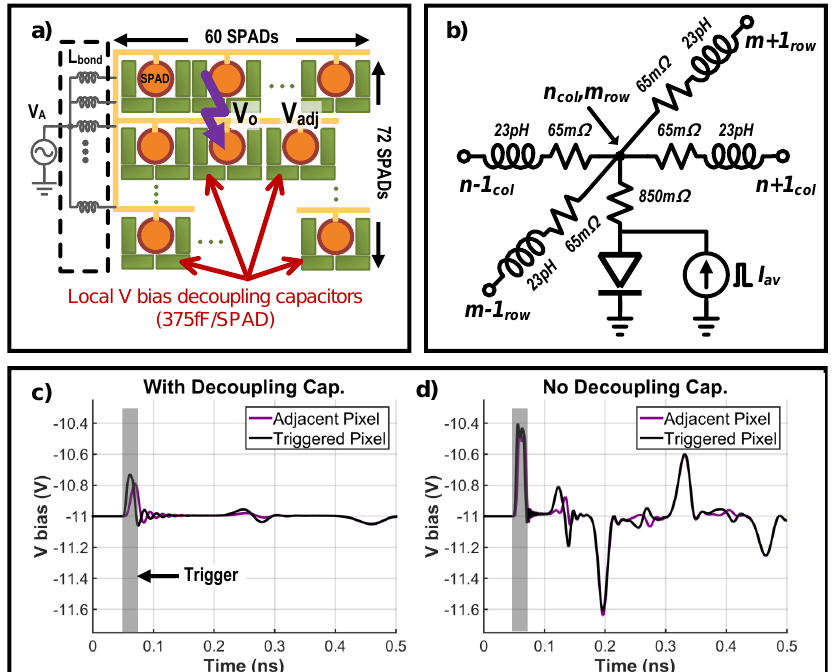
Figure 9. ( a ) Schematic of SPAD reverse bias network with local decoupling capacitors, ( b ) SPAD bias network impedance model. ( c ) Simulated SPAD reverse bias voltage with decoupling capacitor ( d ) Simulated SPAD reverse bias voltage without decoupling capacitors where red and black lines depict avalanche pixel and neighboring pixel